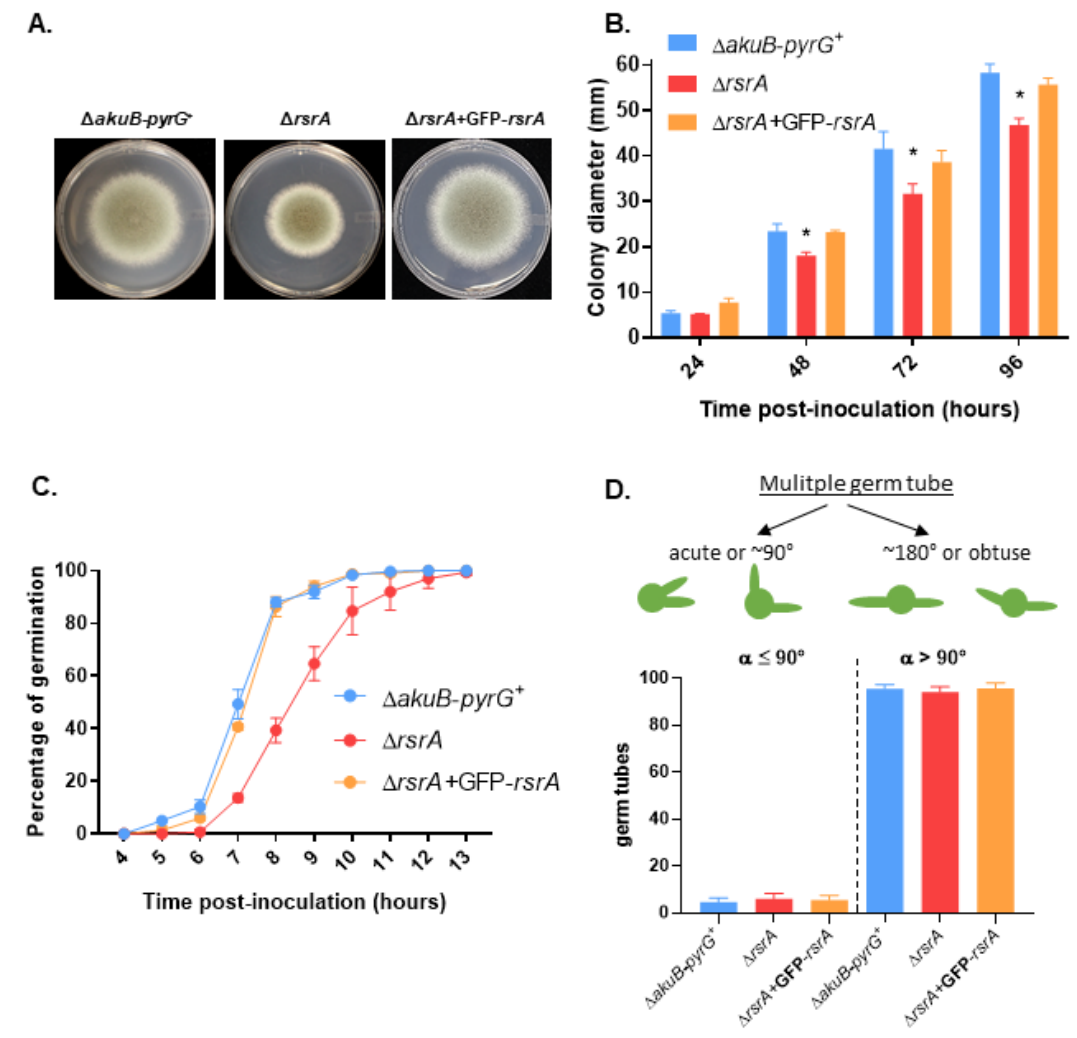
Figure 1. Deletion of rsrA causes decreased colony development and delayed polarity establishment. ( A ) Colony morphology of the control ( ∆ akuB - pyrG + ), rsrA deletion ( ∆ rsrA ) and complemented ( ∆ rsrA + GFP- rsrA ) strains. Glucose Minimum Medium (GMM) agar plates were